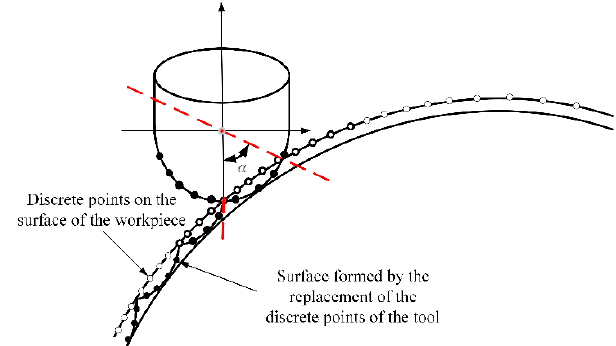
Figure 8. Substitution process of coordinates of discrete points of workpiece.